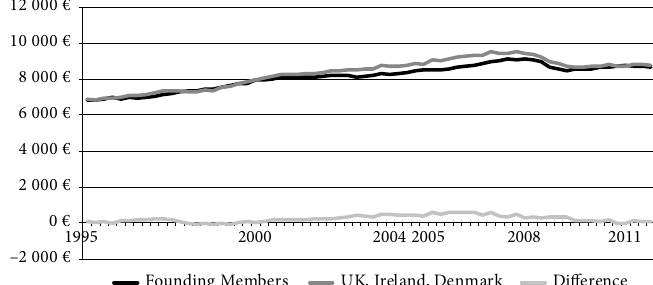
Fig. 4. Convergence in GDP per capita of EU founding members vs. UK, Ireland and Denmark Source : own results.